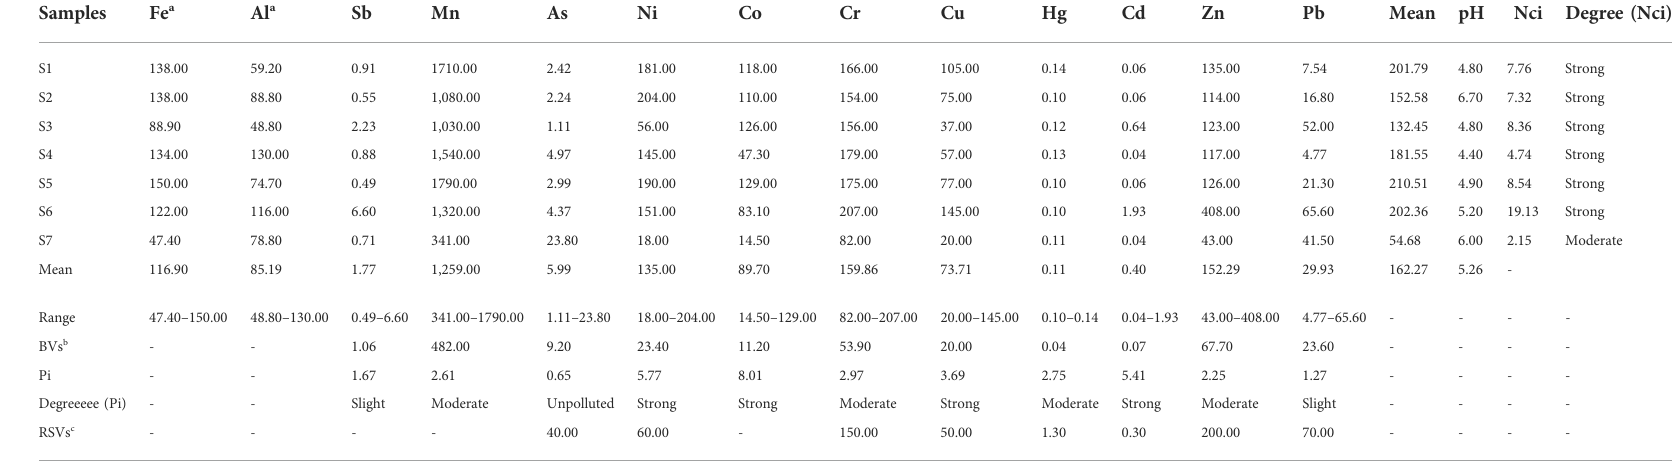
TABLE 2 The concentration (unit: mg.kg − 1 ) and contamination assessment of metals in soils around the MSW incinerator. Samples Fe a Al a Sb Mn As Ni S1 138.00 S2 138.00 S3 88.90 S4 134.00 S5 150.00 S6 122.00 116.00 Strong S7 47.40 78.80 341.00 Mean 116.90 85.19 1,259.00 Range - - BVs b - - 1.06 482.00 Pi - Degreeeee (Pi) - - Slight